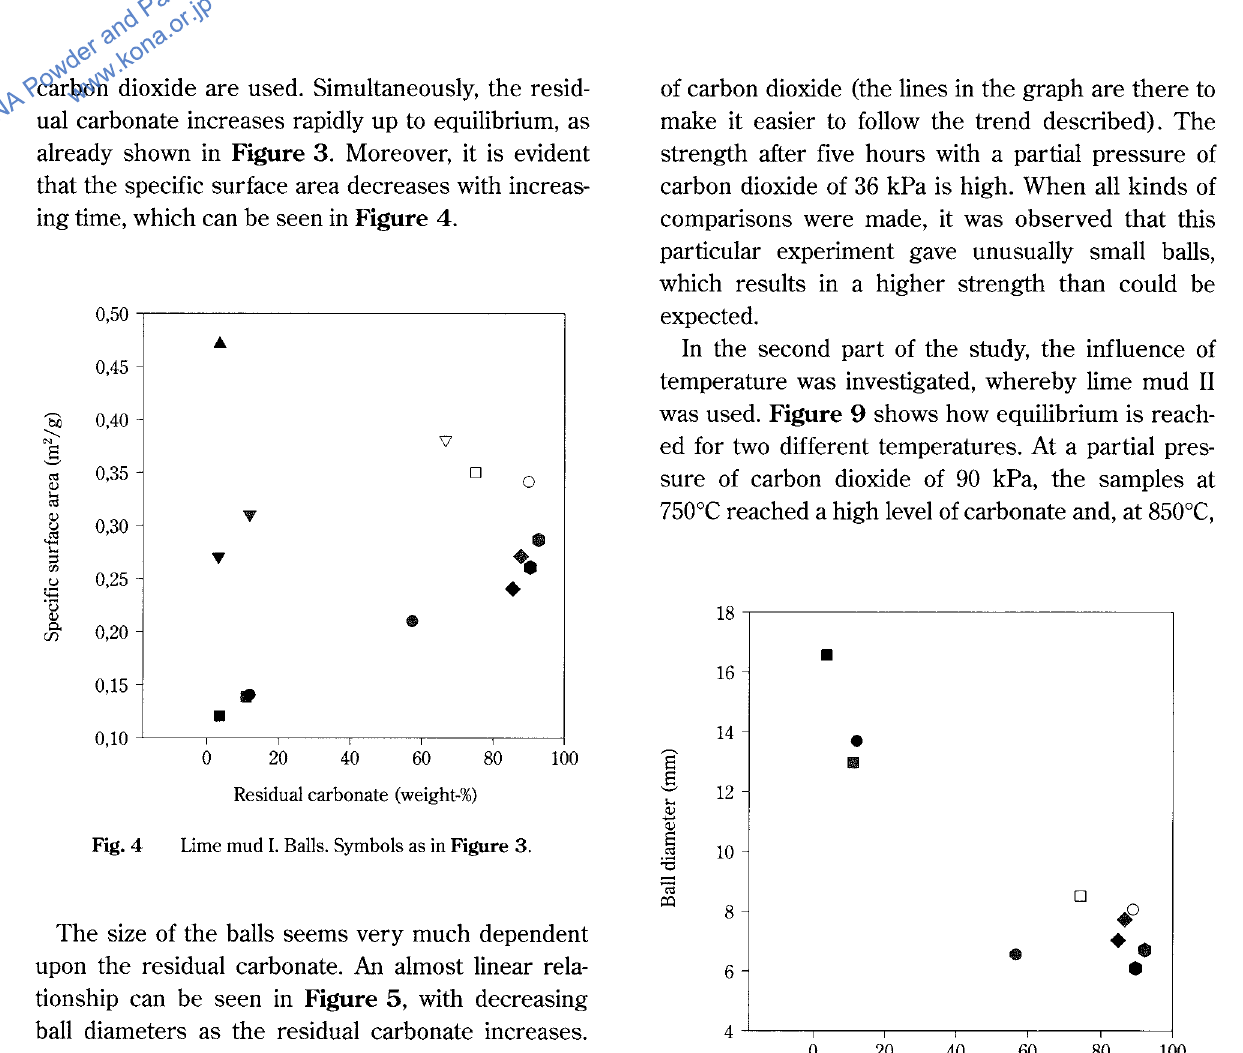
Fig.5 Lime mud I. Balls. Symbols as in Figure 3.